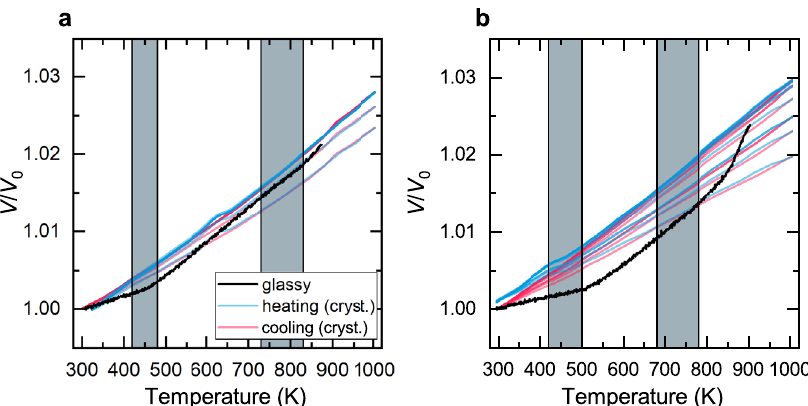
Fig. 3 Relative volume change obtained from the diffraction peaks in crystallized QNb and QMo. In the crystalline state, the alloys a QNb and b QMo do not show the Invar effect anymore. The volume change of the glassy alloys revealing the Invar effect is shown in black as a reference. The temperature intervals of the magnetic phase transitions of the crystalline alloys as obtained from magnetometry (see below) are shaded